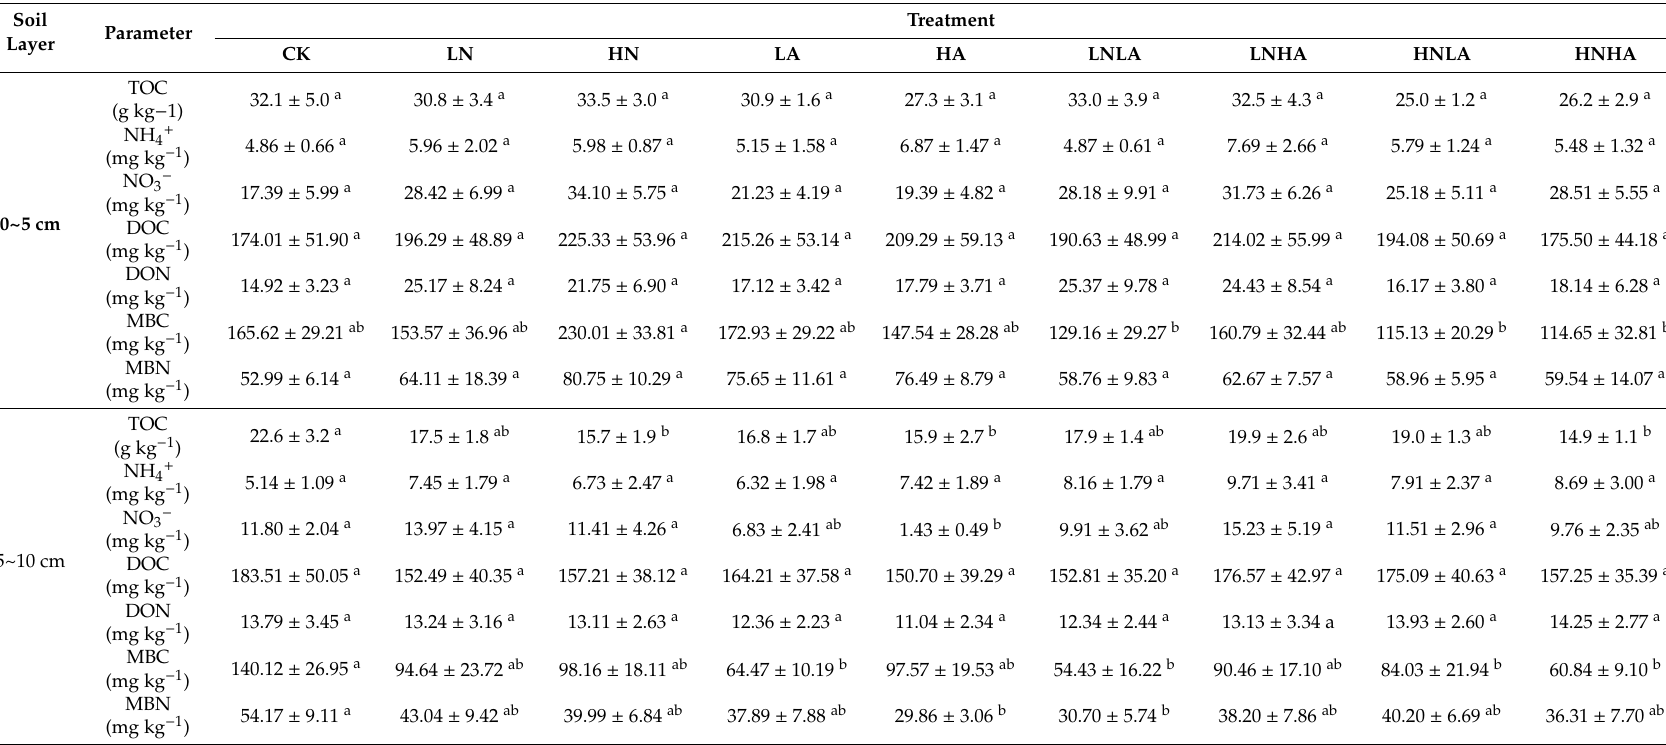
Table 3. Soil properties in the top two soil layers under di ff erent experimental treatments. Data are the means ± standard error ( n = 8); di ff erent letters in one row indicate a significant di ff erence under di ff erent treatments at a 0.05 level ( p <